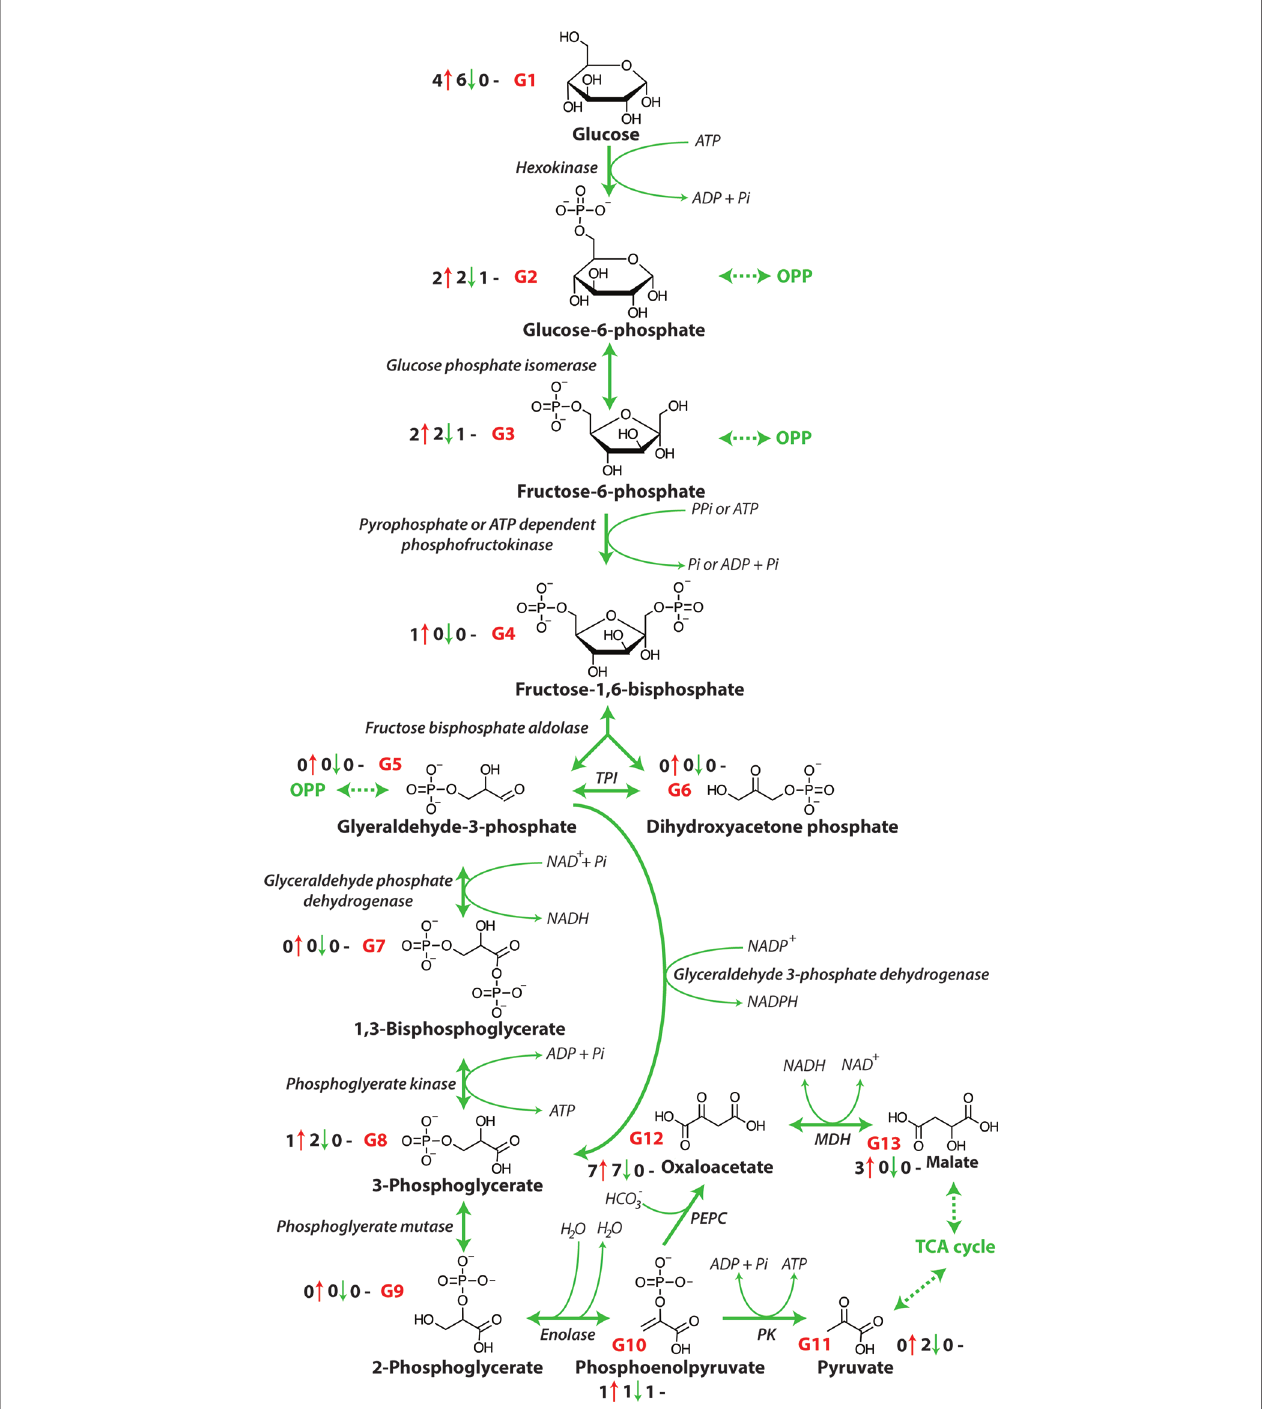
FIGURE 1 | The glycolytic pathway. OPP, Oxidative pentose phosphate pathway; PPi, pyrophosphate, Pi, inorganic phosphate; TPI, triose phosphate isomerase; NAD + , nicotinamide adenine dinucleotide (oxidized); NADH, nicotinamide adenine dinucleotide (reduced); NADP + , nicotinamide adenine dinucleotide phosphate (oxidized); NADPH; nicotinamide adenine dinucleotide phosphate (reduced); ATP, adenosine triphosphate; ADP, adenosine diphosphate; MDH, malate dehydrogenase; PEPC, phosphoenolpyruvate carboxylase; PK, pyruvate kinase. G1-G13 represent each metabolite of glycolysis and the number before the red arrows indicate the number of papers that report an increase in abundance, the number before the green arrows indicates the number of papers that report a decrease in abundance, and the number before the black dashes indicates the number of papers that report no change in